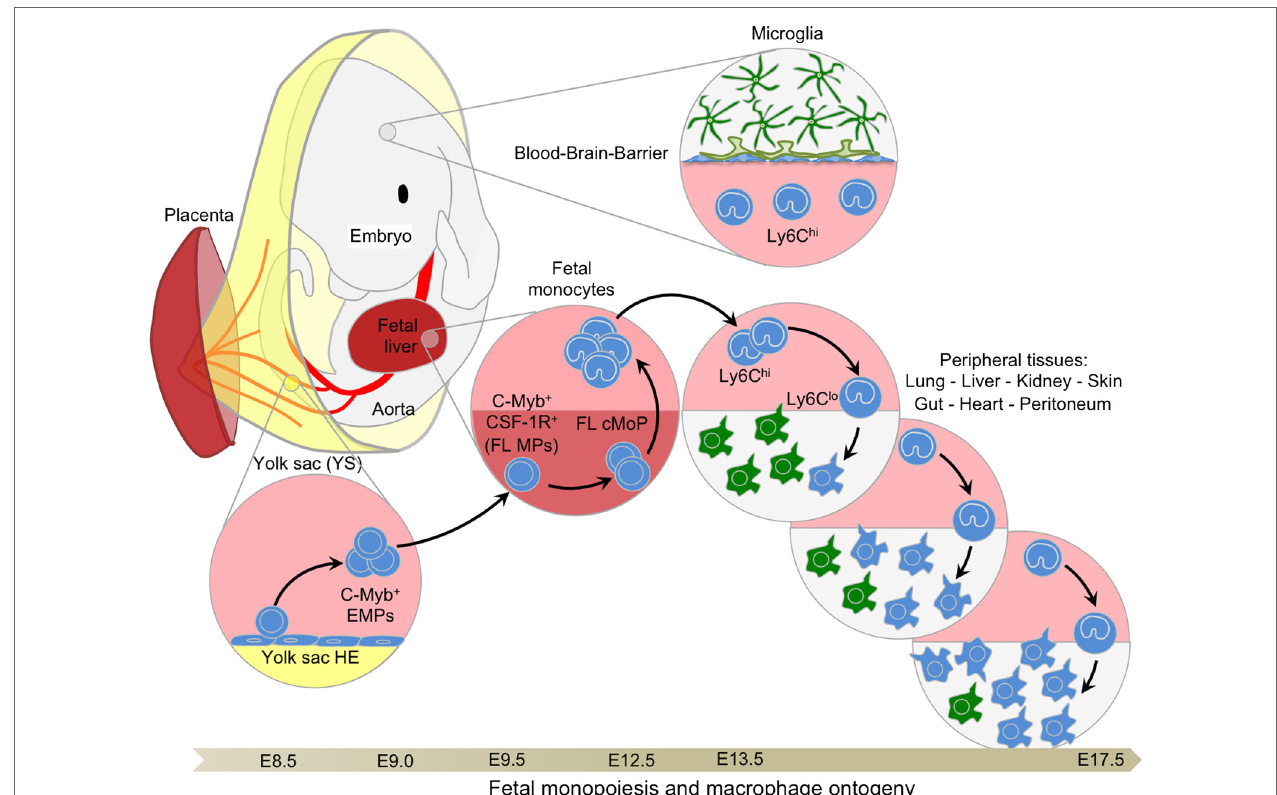
FiGURe 3 | Fetal monopoiesis and macrophage ontogeny . At E8.5 as the blood circulation is established, the YS HE, possibly in conjunction with other hemogenic sites, generates EMPs expressing CD41 and c-Myb. These late EMPs seed the fetal liver around E9.5 where they expand rapidly to give rise to CSF-1R + myeloid progenitors that are able to generate fetal monocytes through cMoP intermediates at E12.5. Fetal monocytes then spread via the blood circulation to all tissues, with the exception of the brain, which is isolated by the establishment of the blood–brain barrier at approximately E13.5. In the tissues, fetal monocytes begin to differentiate into macrophages, progressively outnumbering the previously established primitive macrophages. These fetal monocyte-derived macrophages maintain the capacity to self-renew throughout adulthood in certain tissues, such as the liver or the lung, where they will not be replaced by adult BM-derived